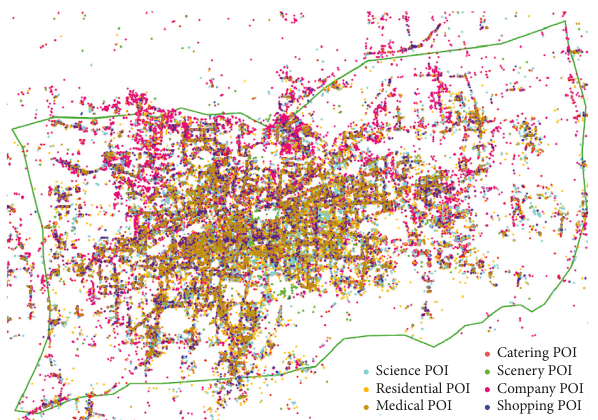
Figure 7: POI of the study area.